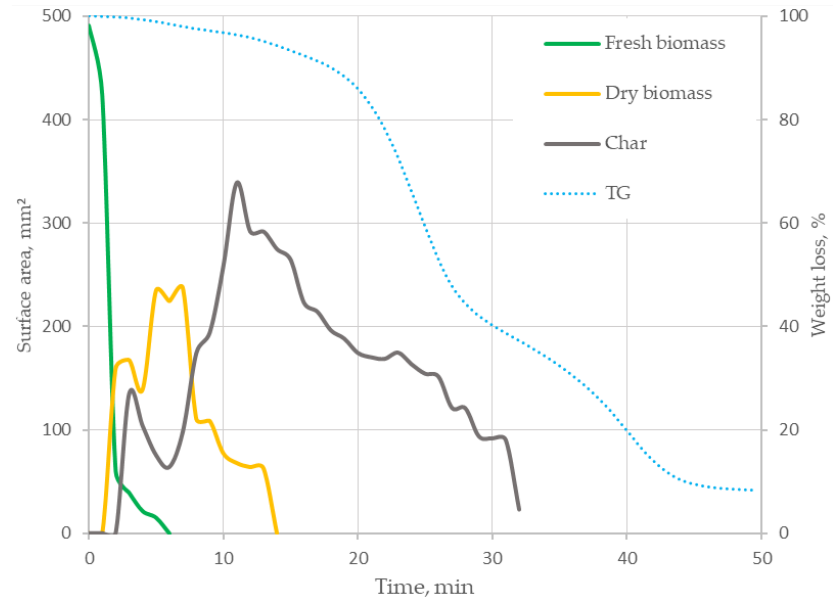
Figure 5. Change in the surface area of fresh biomass, dry biomass and char — sample 10K90J.